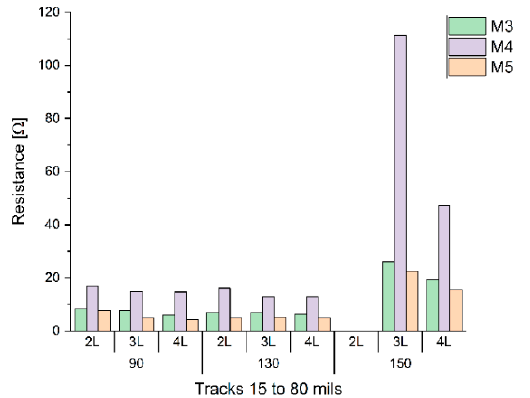
Figure A2. Percentage of all tracks without faults (correct tracks), greater than or equal to 20 mils (0.508 mm), based on inks, number of prints, and mesh size.